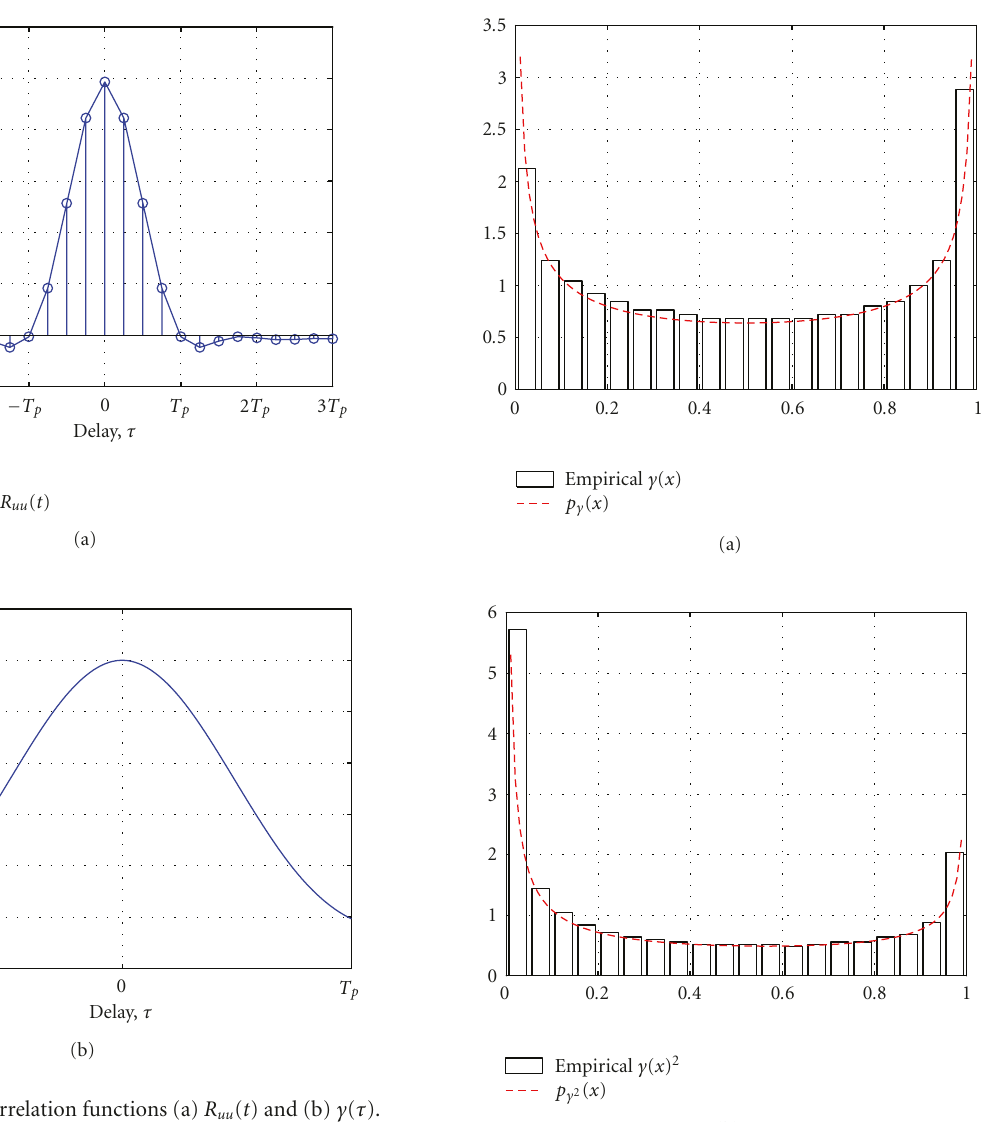
Figure 7: Evaluated correlation functions (a) R uu ( t ) and (b) γ ( τ ).